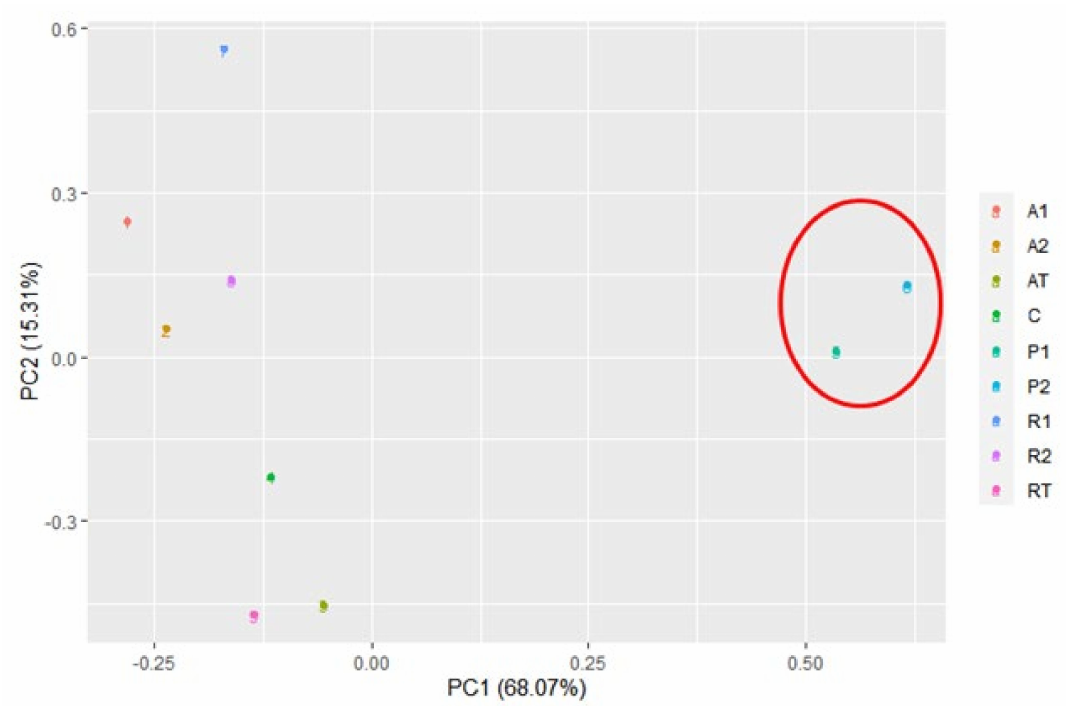
Figure 5. Principal Component Analysis (PCA) of bee bread and bee pollen samples based on major bacterial genera (A1 and A2 = bee breads collected from two colonies fed with oak pollen patty; R1 and R2 = bee breads collected from two colonies fed with rapeseed pollen patty; AT = bee bread collected from colony fed on oak pollen patty with restricted inflow of pollen from outside; RT = bee bread collected from colony fed on rapeseed pollen patty with restricted inflow of pollen from outside; P1 and P2 = bee pollen collected from bee hives equipped with pollen trap; C = bee bread collected from control hive). The red circle clearly indicated the clustering of bee